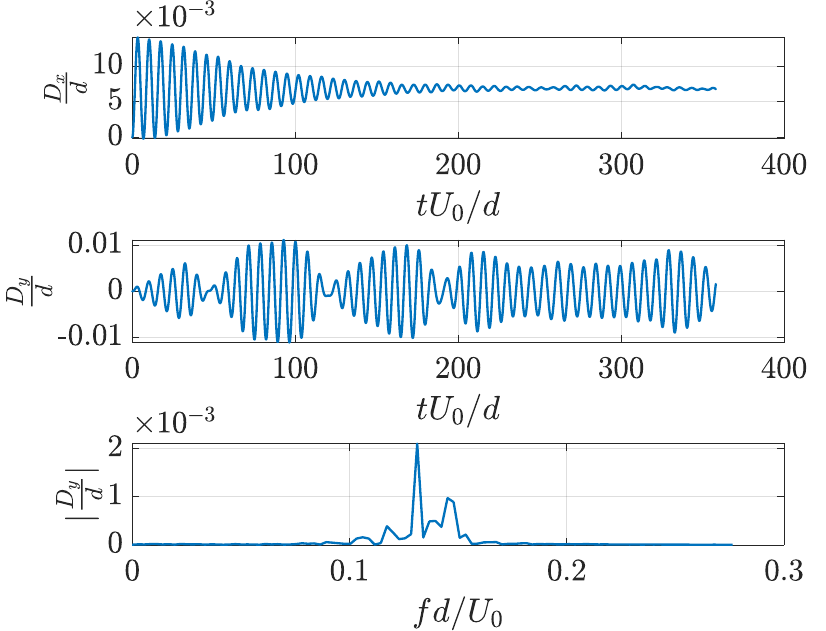
Figure 7. Time record of the displacement of the edge of the cylinder: displacement along the direction of motion ( top panel); displacement along the transversal direction ( middle panel), spectrum of the transversal displacement ( bottom